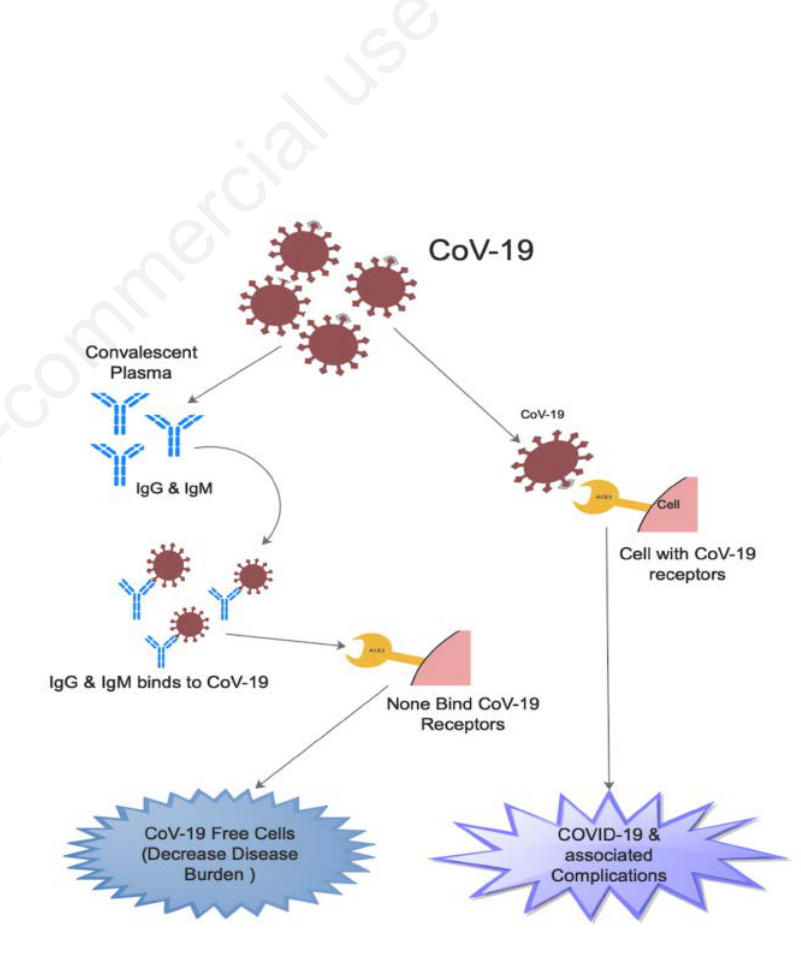
Figure 2. An illustration showing the mechanism via which the IgM and IgG from Convalescent plasma binds to coronavirus-19 (CoV-19) resulting in none binding of CoV-19 receptors as well as decrease coronavirus disease-19